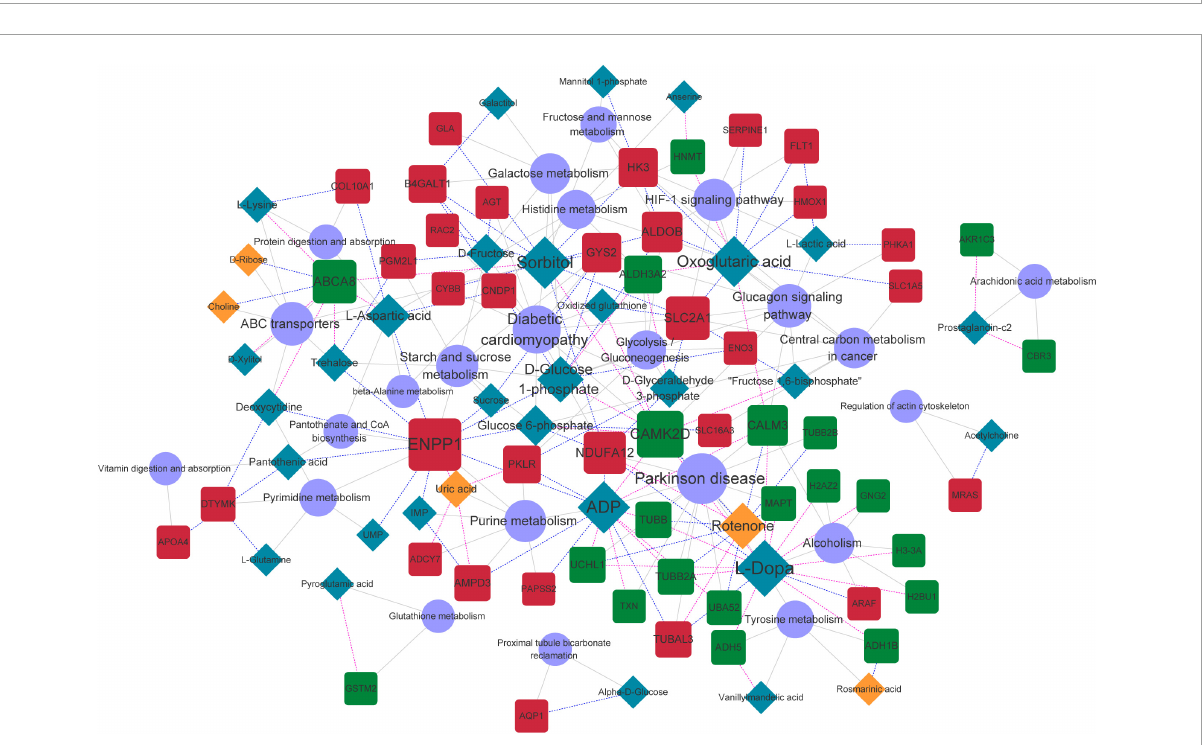
FIGURE7 Metabolite-protein-pathway network. Orange and blue rhombus nodes, upregulated and downregulated metabolites. Red and blue square nodes, upregulated and downregulated proteins. Purple circle nodes, represent KEGG pathways. Node size represents degree of nodes in network. KEGG, Kyoto Encyclopedia of Genes and